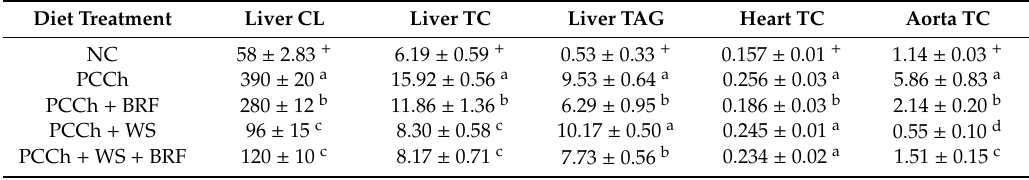
Table 2. Lipid concentration in selected tissues in experimental rats (mg /